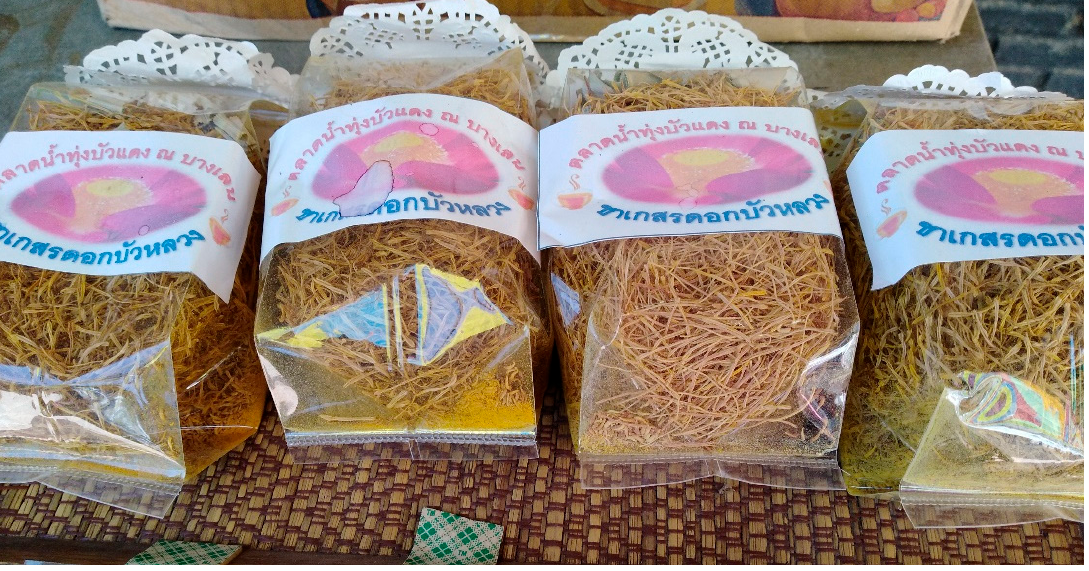
Figure 2. The herbal tea product from stamens of Nelumbo nucifera Gaertn. are sold in local markets. The photo was taken by D.T.